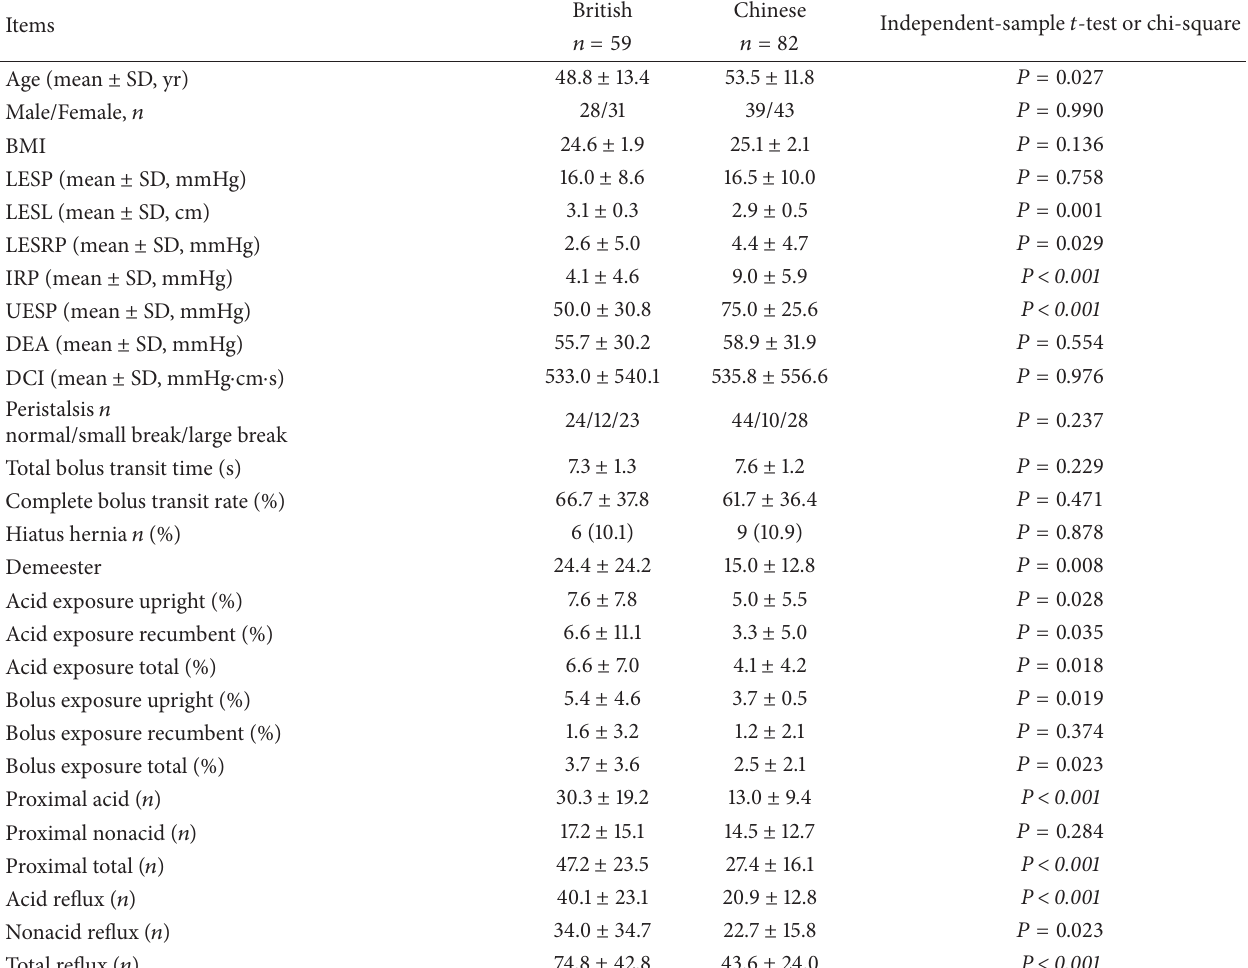
Table 1: Demographic data and high-resolution manometry and impedance results and 24-hour multichannel intraluminal impedance and pH recording of different